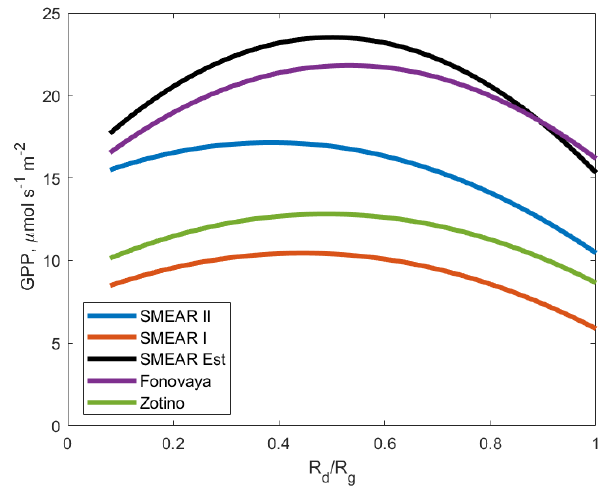
Figure 8. Estimated GPP dependences on R d /R g for all of the sites (obtained as GPP = LUE · PAR using the coefficients for PAR and the LUE dependences on R d /R g reported in Table